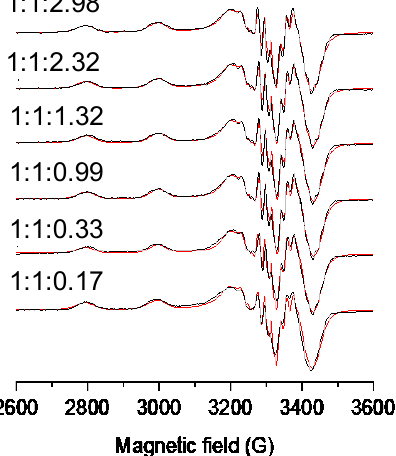
Figure 6. Experimental (black) and simulated (red) anisotropic EPR spectra recorded for the cop- per(II) ‒ STSC ‒ HSA system at pH 7.4 after 4 h equilibration time at 77 K. Numbers above the spectra indicate the copper(II):STSC:HSA ratios. { c Cu(II) = c STSC = 202 μM, c HSA = 0–600 μM; 30% ( w / w ) DMSO/H 2 O; pH = 7.4 (20 mM HEPES); I = 0.10 M (KCl)}.